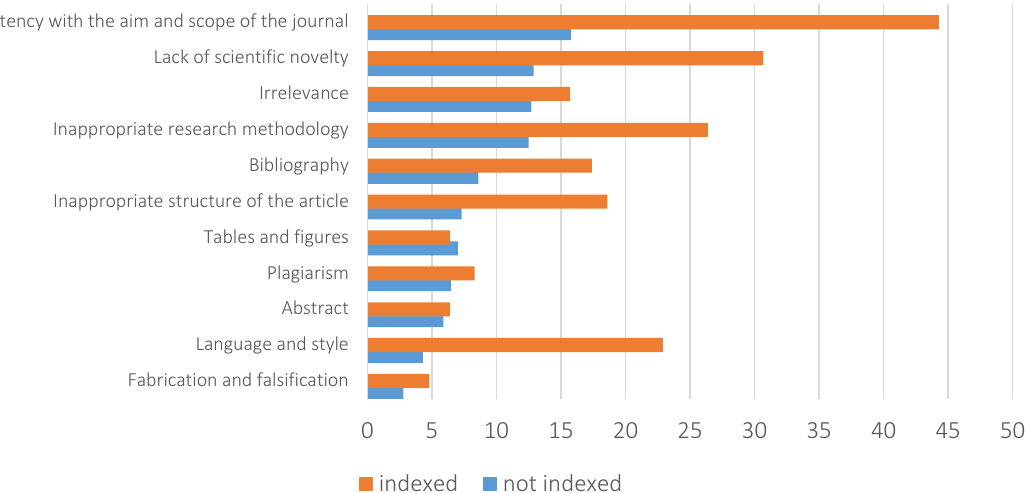
Figure 4. Comparing the reasons for the rejection of articles by journals editors indexed and not indexed by Web of Science and (or) Scopus